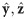
Diagram of a rowing boat under speed with an imperfectly aligned bow-mounted smartphone.The smartphone coordinate system y^,z^ is oriented relative to the horizontal coordinate system y^′,z^′ by a varying pitch angle θ. The accelerometer-reported acceleration α differs from the actual y^′ component because it includes a gravitational component. The actual acceleration a of the phone is then a=α-gz^′. We desire the magnitude of the acceleration a projected onto the horizontal plane but we do not know θ at any given time. As described in the “smartphone acceleration” section, the sensed y^ acceleration differs from the true y^′ acceleration by a moderate intrinsic bias and a larger term gθ which accounts for the projection of the gravity vector on the pitched y^ axis.